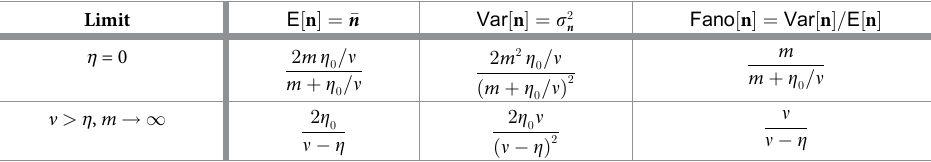
The evolutionarily neutral moment equations, Eqs (23) and (24), make predictions for the mean and variance of TE load in various limits (see Secs 3.2–3.3 of S1 Text). The influence of selection on overdispersion can be understood by